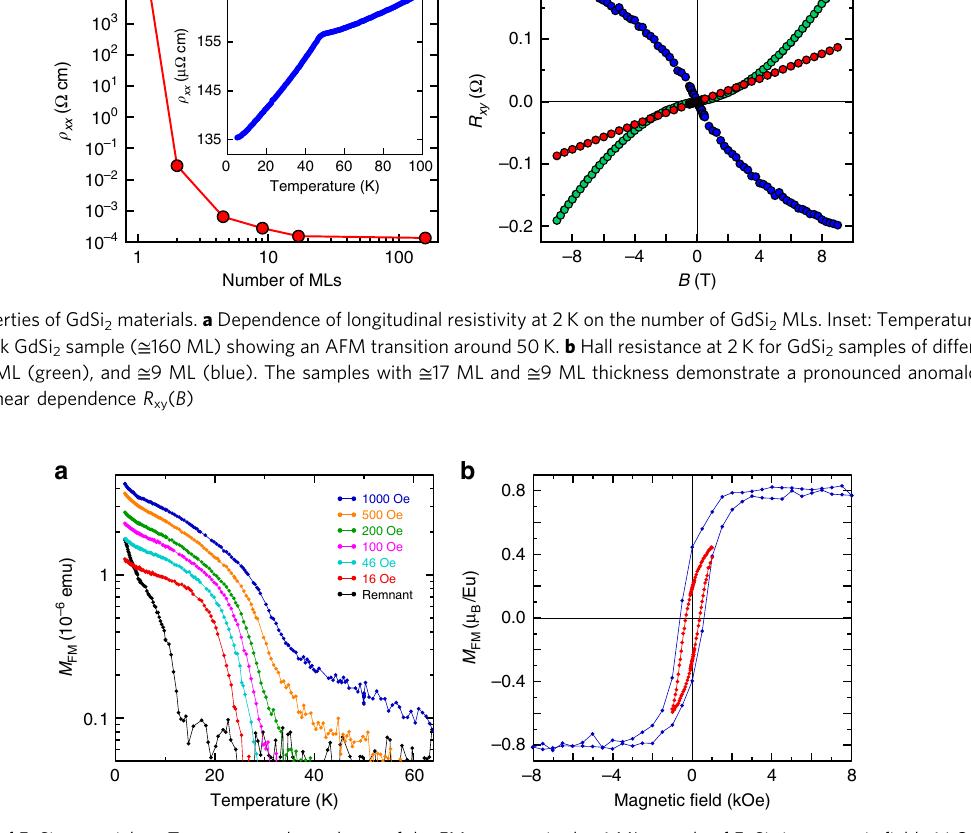
Fig. 5 2D magnetism of EuSi 2 materials. a Temperature dependence of the FM moment in the 4 ML sample of EuSi 2 in magnetic fi elds 16 Oe (red), 46 Oe (turquoise), 100 Oe (purple), 200 Oe (green), 500 Oe (orange) and 1 kOe (blue), as well as remnant moment (black). b Magnetic fi eld dependence of the FM moment in the 4 ML sample of EuSi 2 at 2